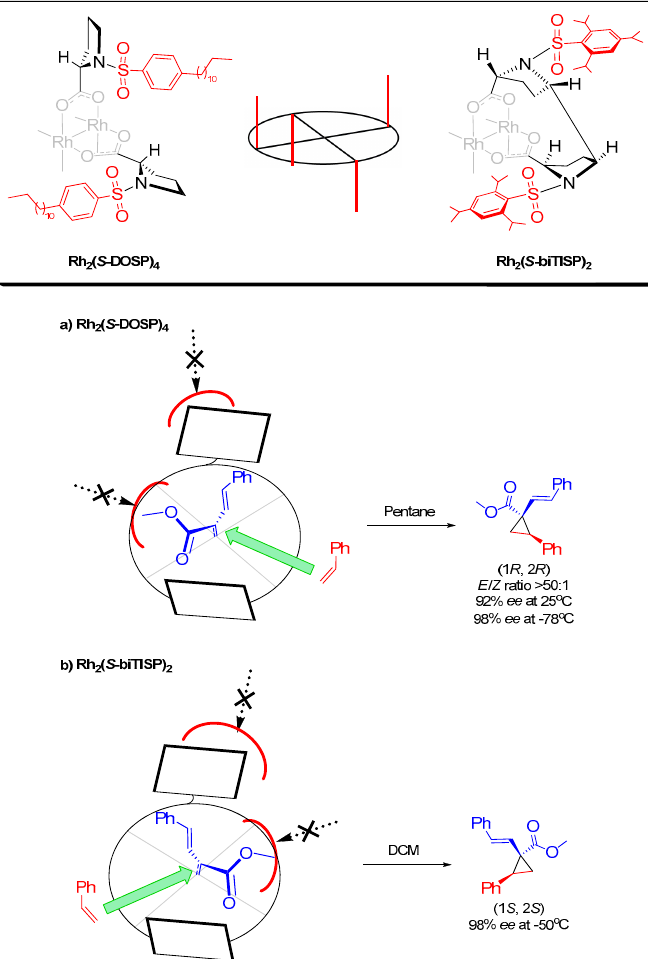
Scheme 2. Structure, D 2 -symmetry and facial enantioselectivity in enantioselective cyclopropanation of styrene with methyl styryldiazoacetate of Rh 2 ( S -DOSP) 4 and Rh 2 ( S -biTISP) 2 as proposed by Davies et